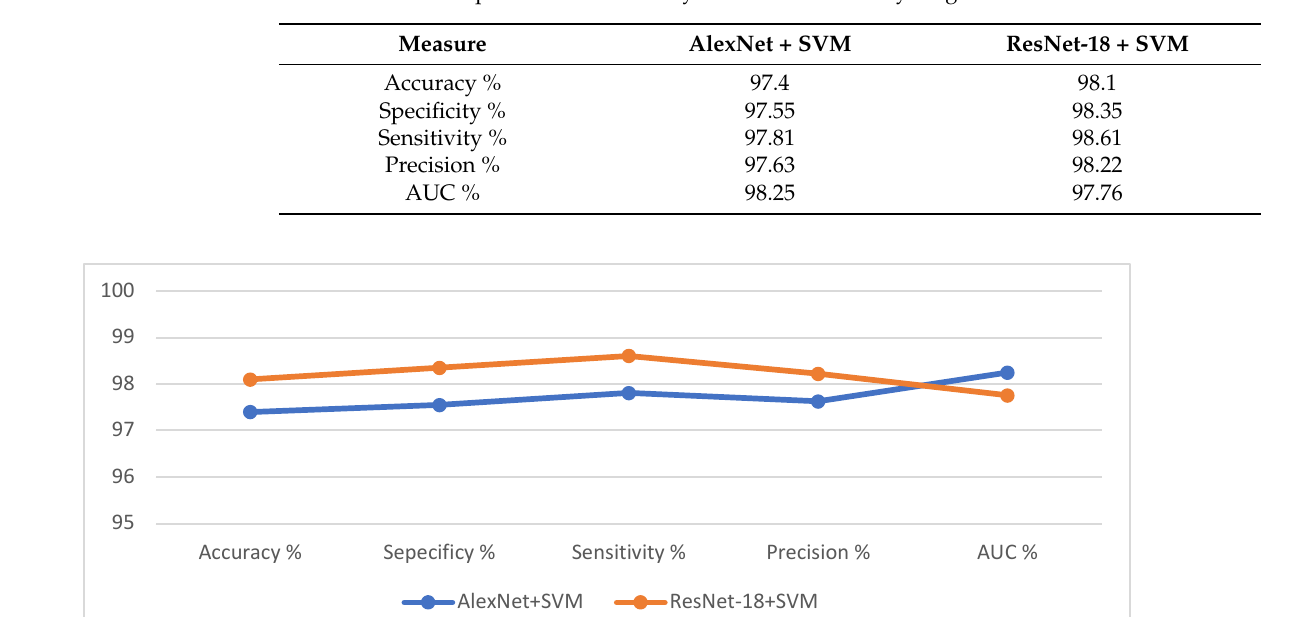
Table 3. Evaluative performance of the hybrid method for early diagnosis of OSCC.